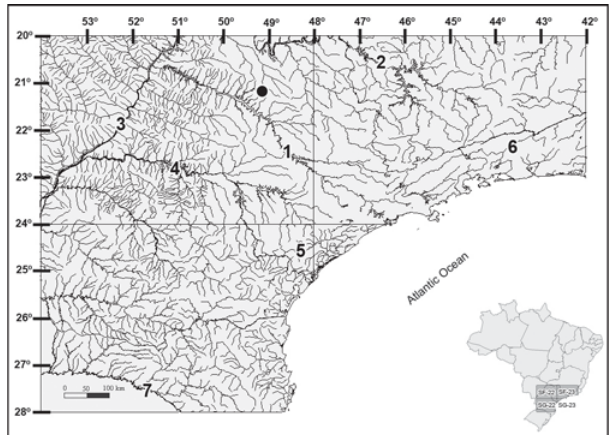
Fig. 2. Southeastern Brazil showing type-locality